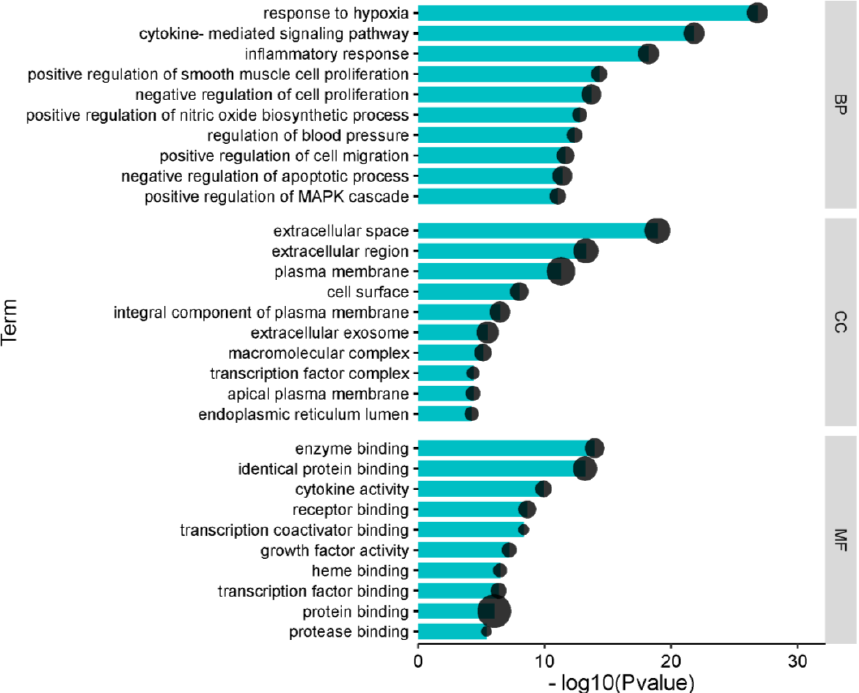
Figure 4. Gene Ontology (GO) analysis of the 114 overlapping gene symbols associated with heart failure. BP represents the categories of “biological process” , CC represents the categories of “ cellular component ” , and MF represents the categories of “ molecular function ” . Black nodes represent gene numbers. gene